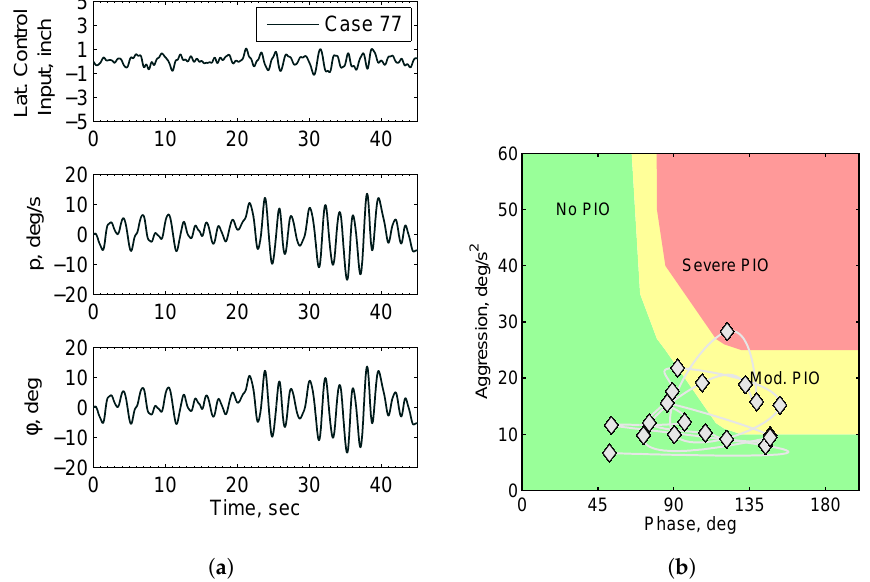
Figure 15. Results from lateral reposition, Case 77-Day 1-APC = 4A. ( a ) Time recording; ( b ) PAC